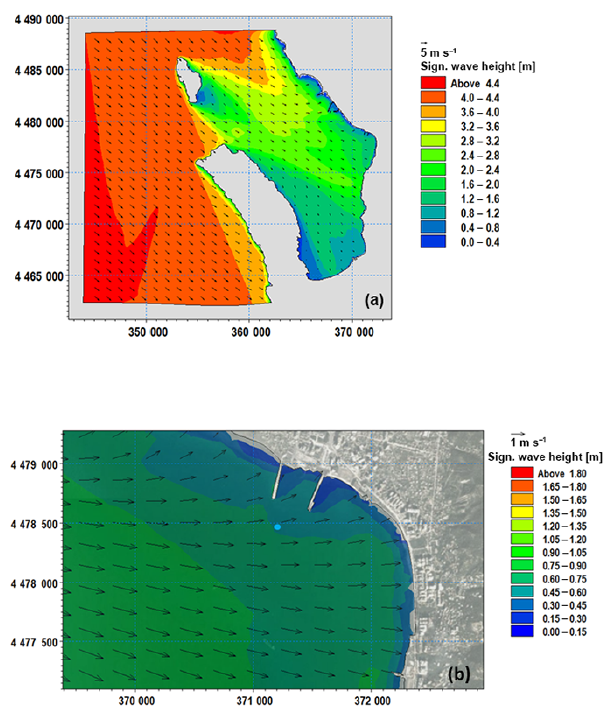
Figure 5. Wave field for the design wave condition H S = 4.40m, T p = 8.5s, Dir = 310 ◦ N. (a) Entire domain, (b) harbour entrance. The blue bullet is the extraction point location; its UTM coordinates are 371221 ◦ E, 4478470 ◦